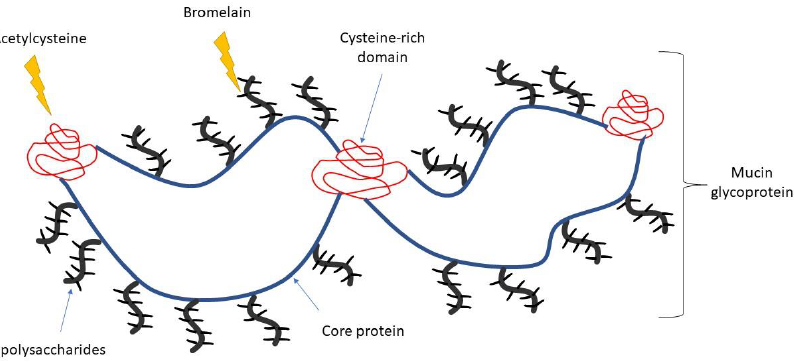
Figure 7. An illustration showing bromelain hydrolysis of glycosidic linkages that are abundant in mucin, whilst N-acetylcysteine reduces the di-sulfide linkages that are abundant cystine-rich domains in mucinous mass.